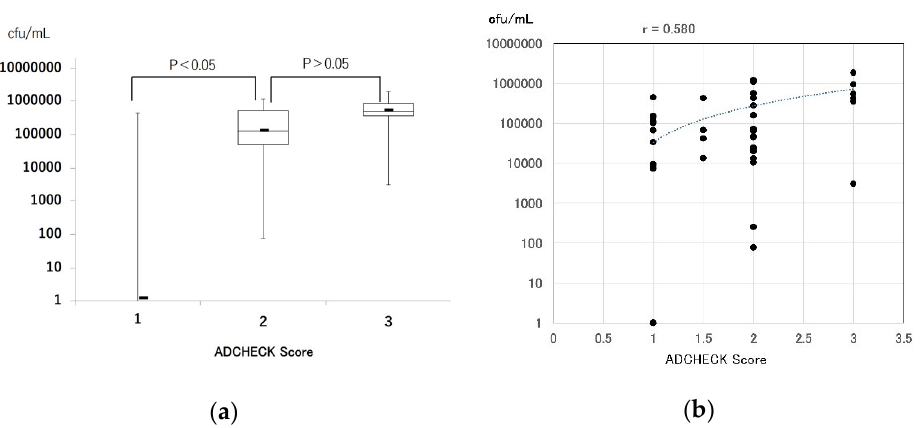
Figure 3. Comparison of the number of red-complex bacteria determined by real-time PCR per ADCHECK score value in tongue-coat samples. ( a ) bar graph and ( b ) scatter plot.